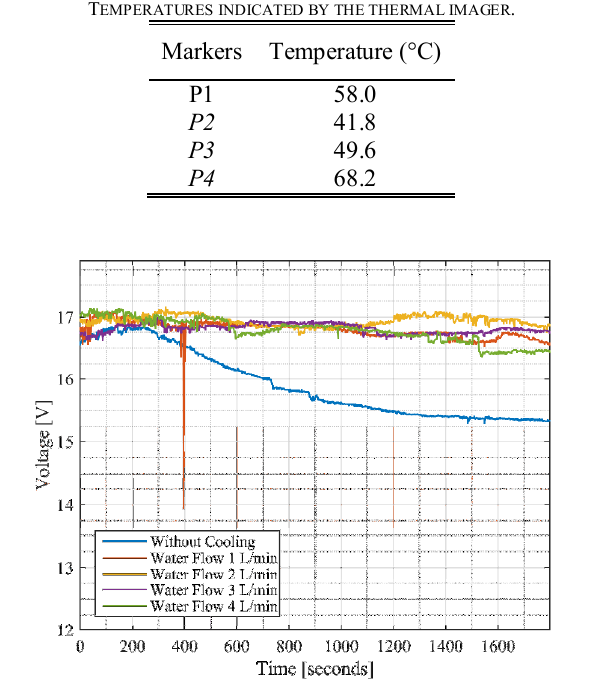
Fig. 6. Thermal image of the photovoltaic panel when the water flow is 2 L/min. TABLE I T EMPERATURES INDICATED BY THE THERMAL IMAGER .